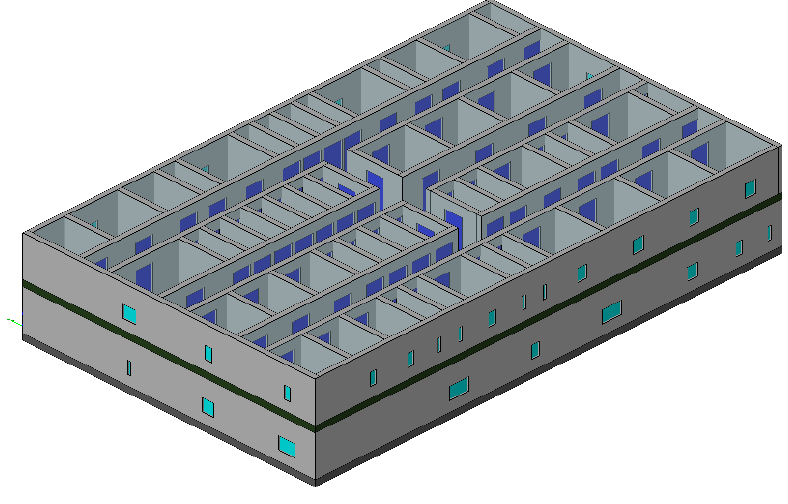
Figure 4. IFC model